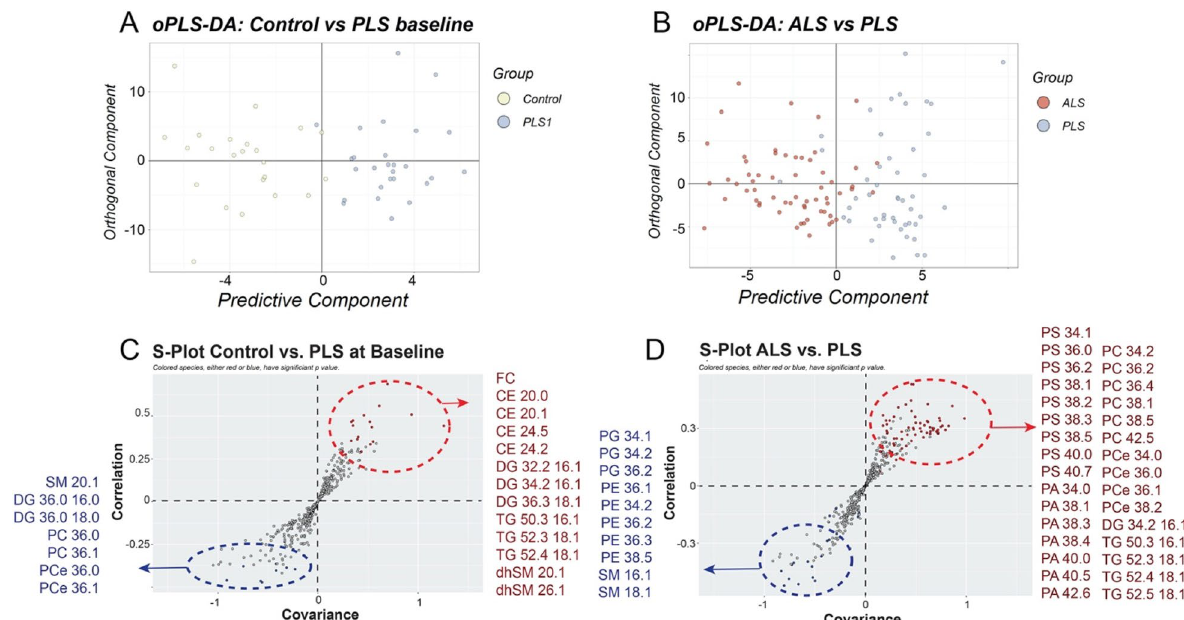
Figure 2. oPLS-DA score plots and corresponding loading S-Plots obtained from ( A ) control and PLS plasma samples at baseline and ( B ) pooled ALS and PLS plasma samples. OPLS-DA loadings S-plots indicate significant lipids species between ( C ) controls and PLS at baseline and ( D ) between all ALS and PLS plasma